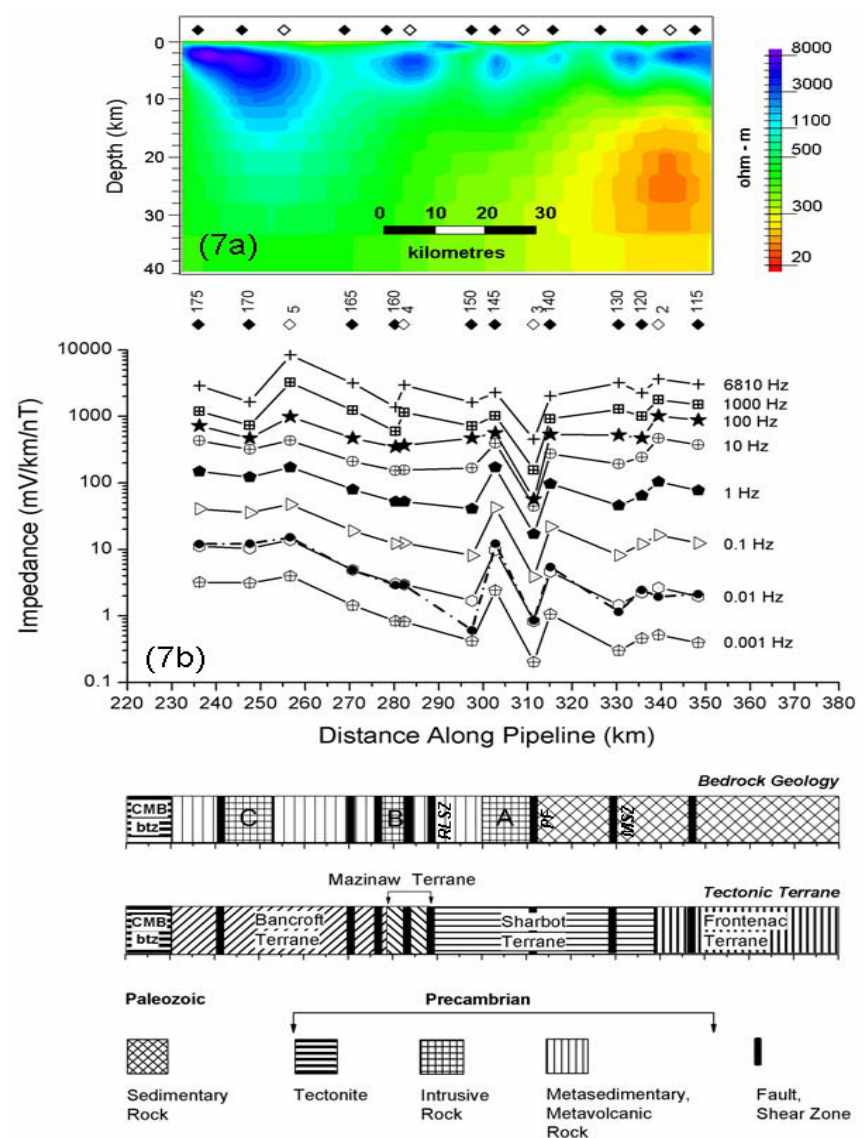
Figure 7. Fig. 7. (a) Resistivity cross-section (TM component) beneath pipeline. (b) Measured Z yx (45) surface impedance (dashed line) at 0.01Hz used as input to pipeline modelling and modelled response Z yx impedance (solid lines) – at eight different frequencies – obtained from resistivity cross-section. MT sites from 2003 ORV ( ♦ ) and 2005 ORF ( (cid:7) ) surveys, and schematics of exposed bedrock and tectonic terranes along the pipeline route in study area are shown. Abbreviations: A, Pakenham Dome; B, Hurds Lake; C, Bonnechere Ridge; CMBbtz, Central Metasedimentary Belt boundary thrust zone; RLSZ, Robertson Lake Shear Zone; PF, Pakenham Fault; MSZ, Maberly Shear Zone (possible north-eastward